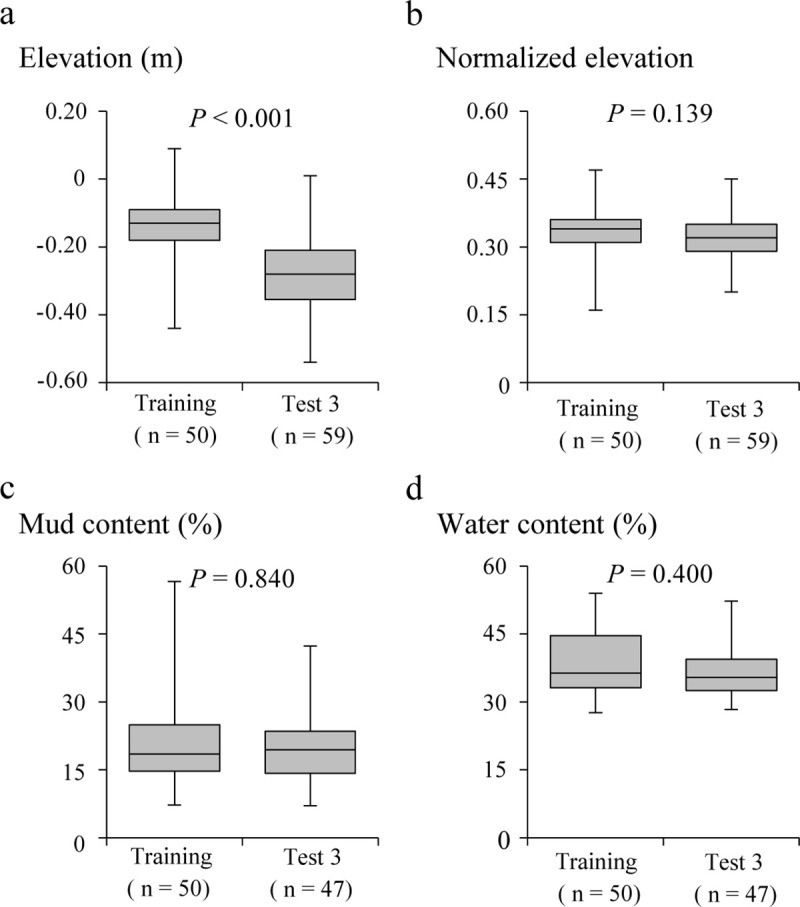
Environmental characteristics of points with detected presence of juvenile horseshoe crab in Tsuyazaki (only Training data) and Imazu (Test data 3): elevation (a), normalized elevation (b), mud content (c), and water content (d). Box plots show the 25th and 75th percentiles and the median. The vertical lines extend to the minimum and maximum values. P-values were based on the result of the Mann–Whitney U test.